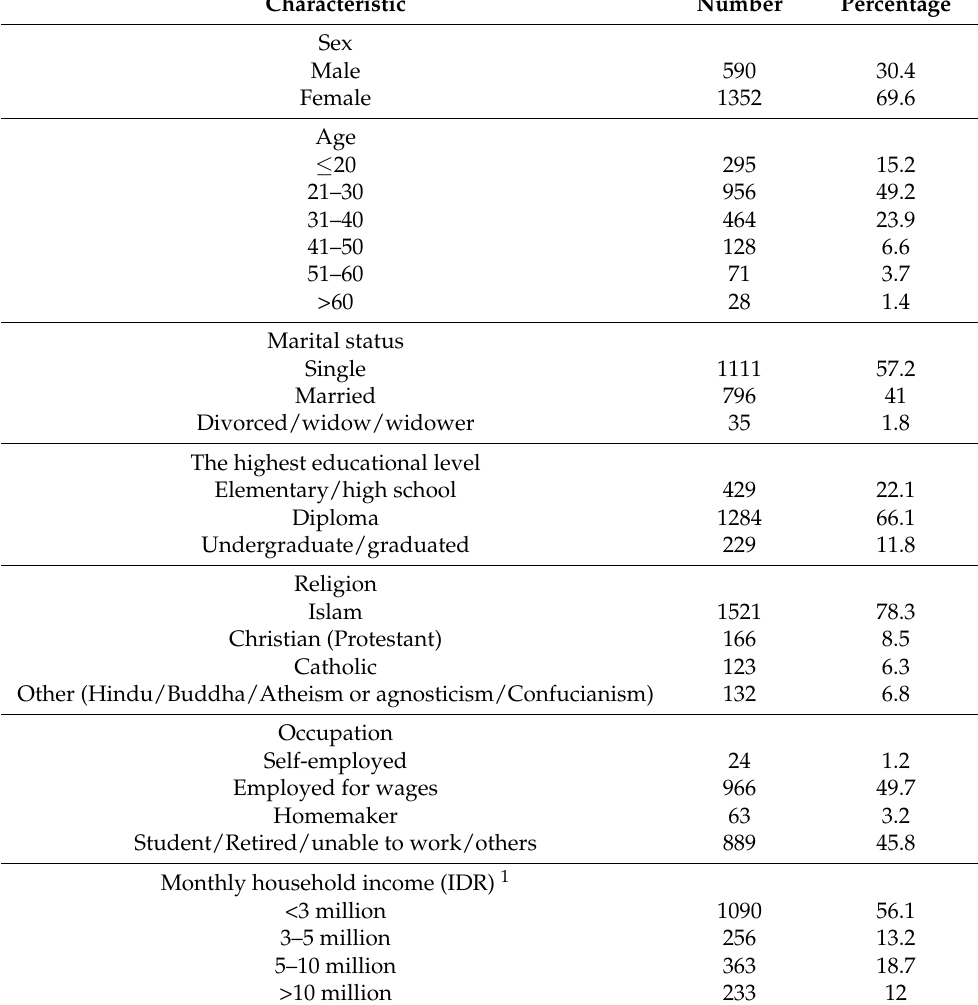
Table 2. Demographic characteristics of the participants who were willing to pay for a booster dose COVID-19 vaccine in Indonesia ( n = 1942).